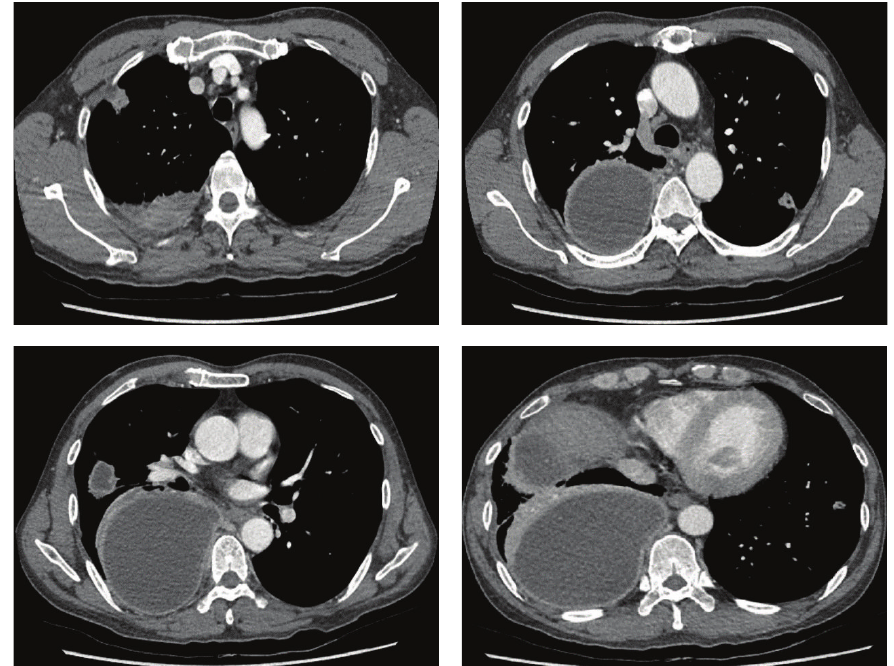
Figure 2: Multiple lung nodules and a large amount of multiloculated pleural effusion in the right